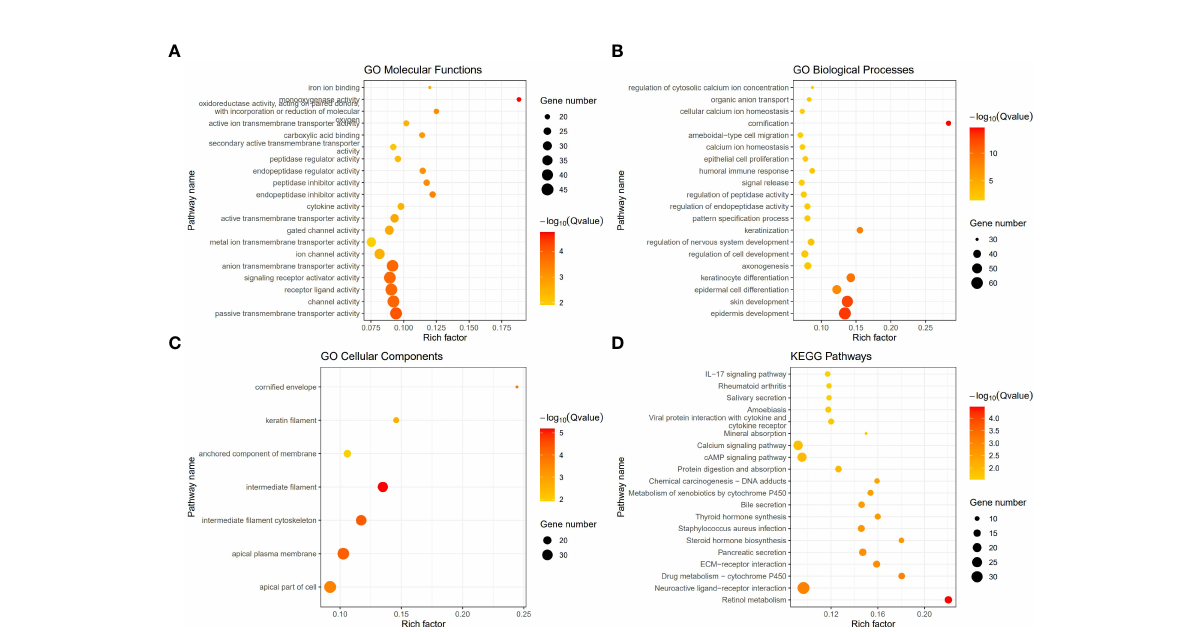
FIGURE 4 The functional enrichment between the two Classes based on DEGs. (A) Barplot graph of the Gene Ontology (GO) Molecular Functions enrichment analysis. (B) Barplot graph of the GO Biological Processes enrichment analysis. (C) Barplot graph of the GO Cellular Components enrichment analysis. (D) Barplot graph of the Kyoto Encyclopedia of Genes and Genomes (KEGG) Pathways enrichment analysis.